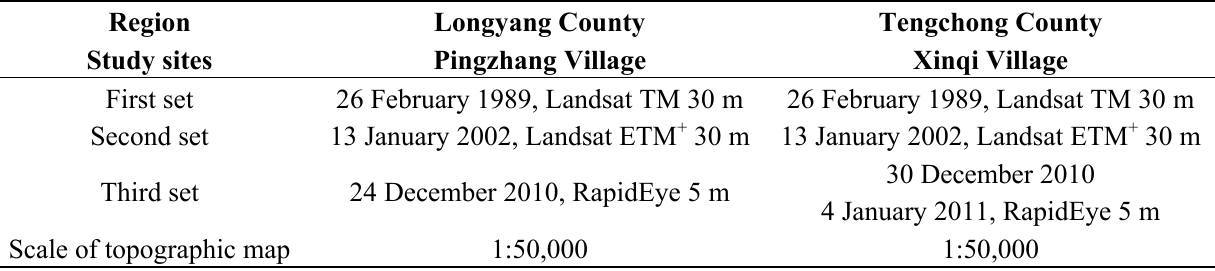
Table 2. Specification of spatial data used for